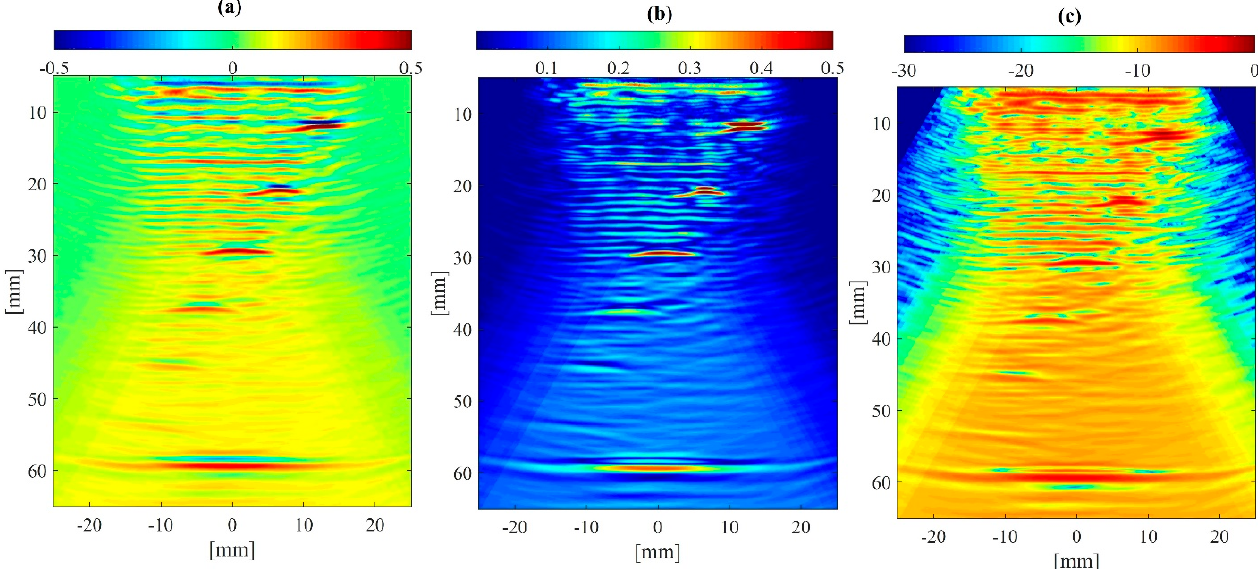
Figure 8. TFM image of the CFRP sample obtained from the FMC data captured using the standard and commercial pulse-echo system. The colormap in the images indicates ( a ) the full-wave amplitude, ( b ) the energy, and ( c ) the energy in the dB scale of the echo signal.